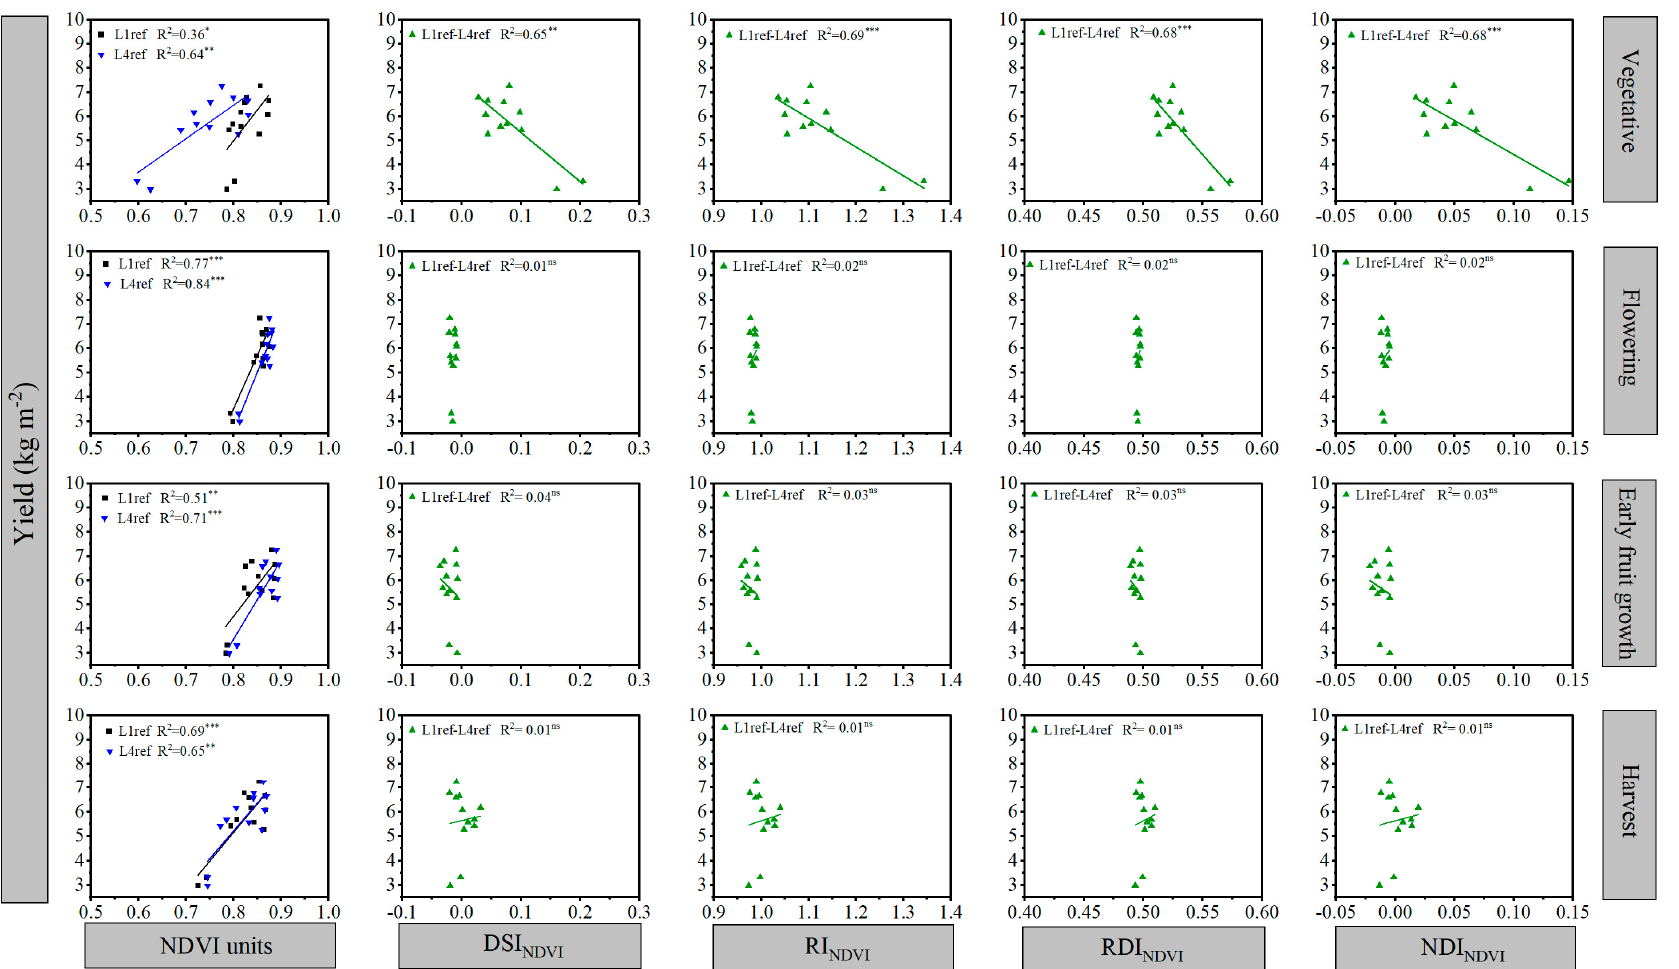
Figure 6. The relationships between absolute NDVI measurements and several normalized NDVI indices (DI, RI, RDS, NDI) with total fruit yield (kg m − 2 ) at different phenological stages of sweet pepper, for calibration data. L1, L2, L3 and L4, refer to the latest (most recent), second, third and fourth fully expanded leaf, respectively. Asterisks show significance of regressions: ***, p < 0.001; **, p < 0.01; *, p < 0.05; ns, p > 0.05.